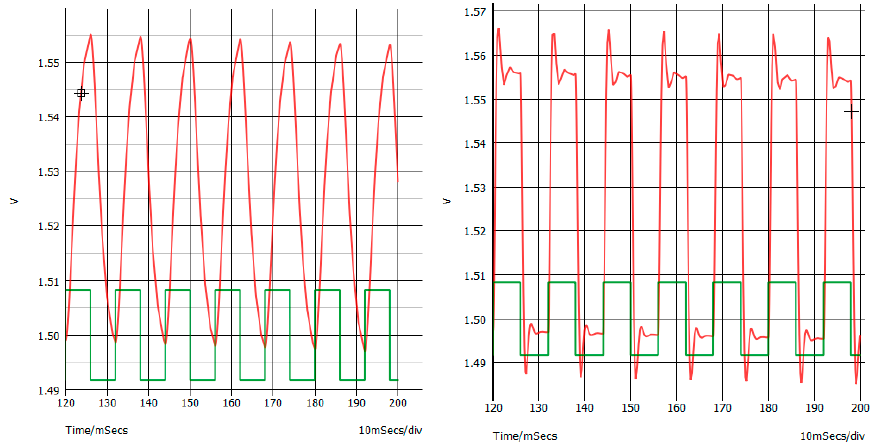
Figure 5. On both sides, the green tracing is the input to the simulated original or modified last stage amplifier of the Olimex board, and the red tracing is the output of the amplifier. Left side: original Olimex ECG/EMG amplifier output. Right side: modified amplifier showing faster slew rate and emphasis (overshot) of the rising signal, which is much more adapted to amplify EMG signal MUAPs or EMG interference signal. Note that overshot can be eliminated using a value of 1.8 nF for the C13 capacitor.